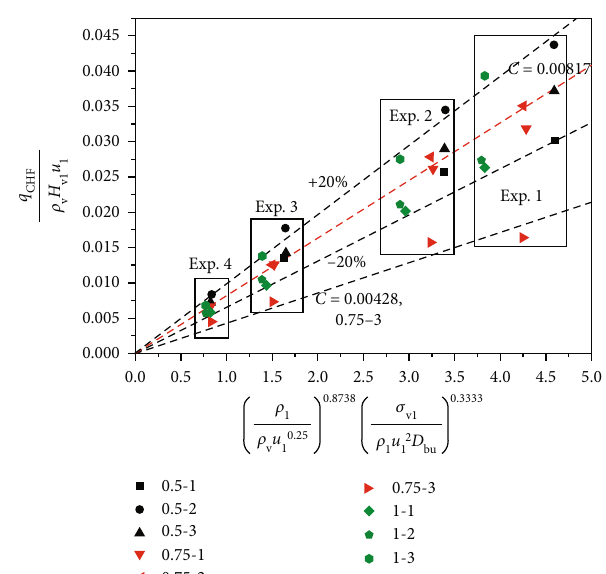
CHF by Equation (17).